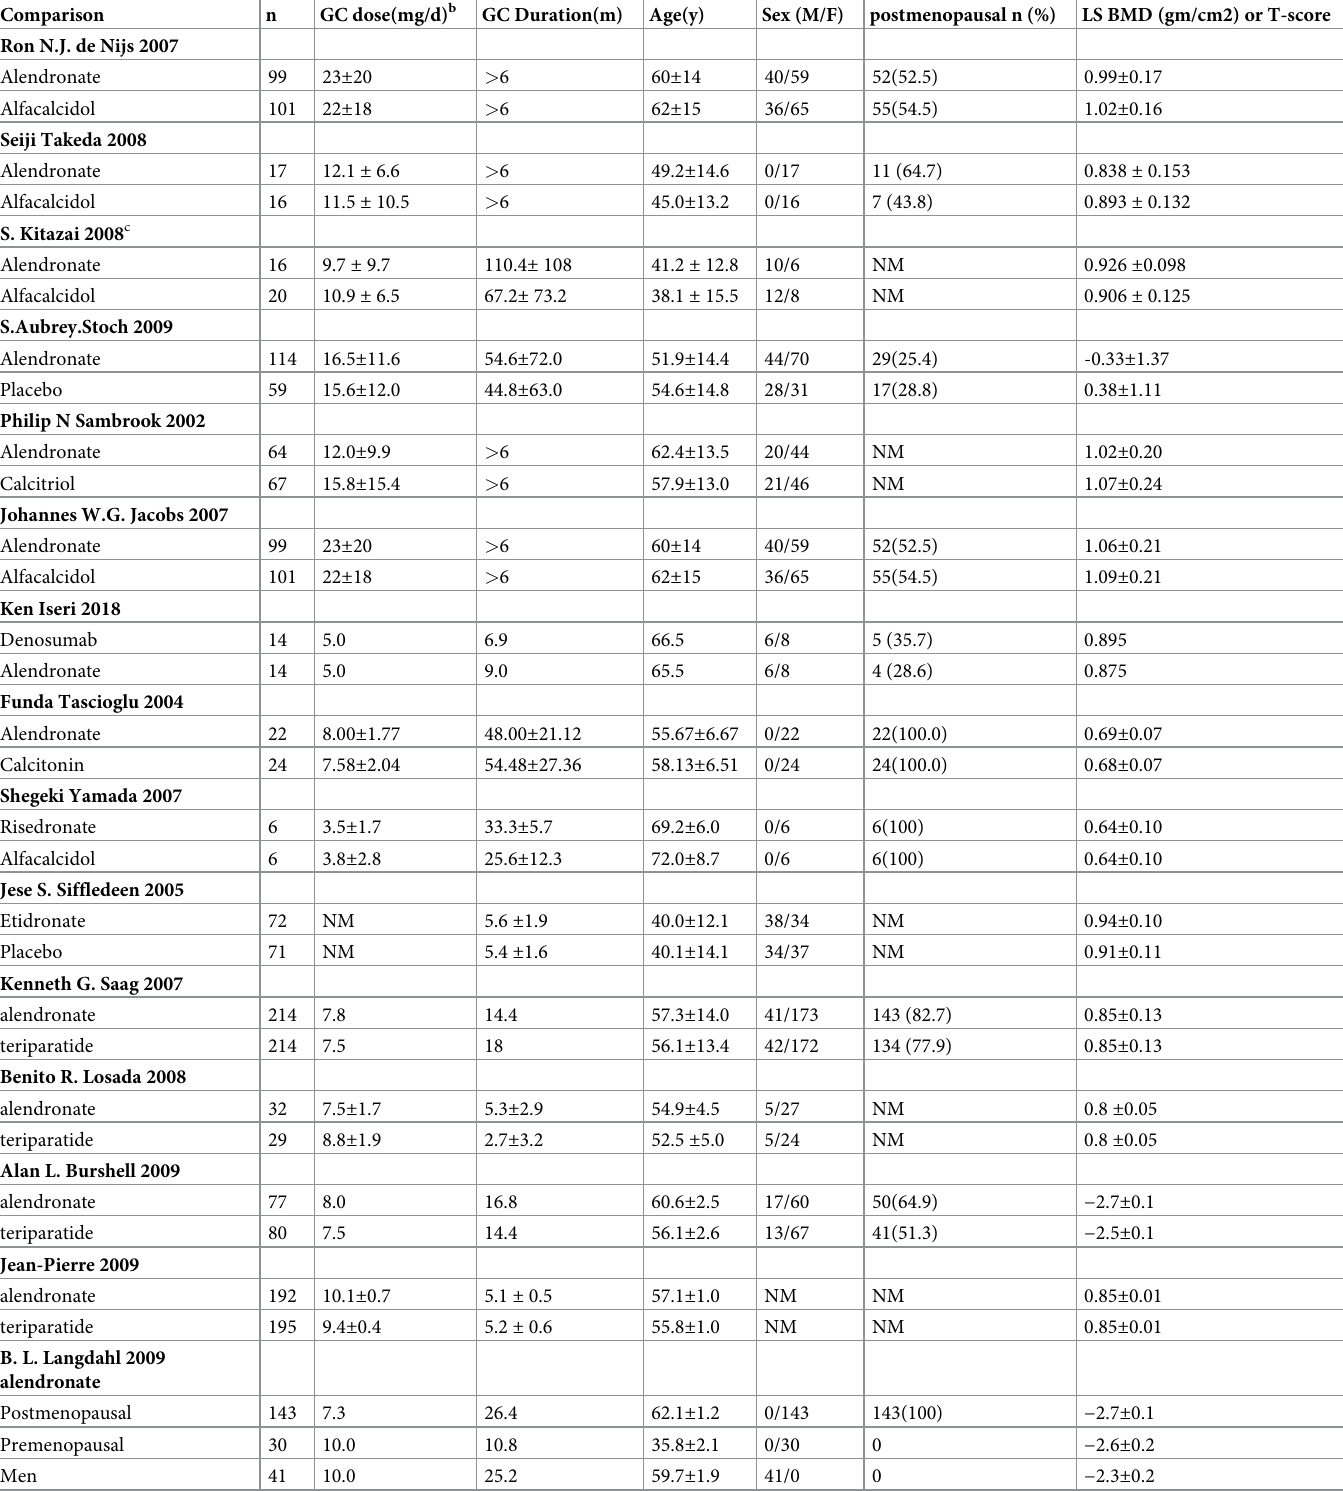
Table 1. Characteristics of the included studies � a